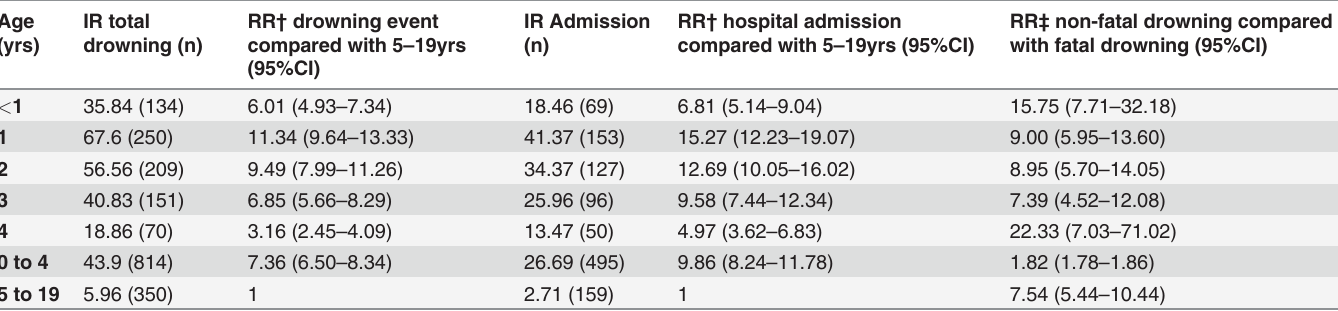
15 – 19yrs: Older adolescents were involved in 12% of incidents overall. Total drowning inci- dence rates almost trebled over the study (X 2 = 6.96; P > 0.01) primarily due to non-fatal events (X 2 = 5.31; P < 0.05). Although the rates for hospital admissions and non-admissions were simi- lar, the non-admission rate increased by a factor of 2.3 (X 2 = 11.12; P > 0.001) over the study. For male adolescents total drowning rates almost doubled (X 2 = 7.06; P < 0.01), and non- fatal and non-admission rates more than doubled (X 2 = 6.13; P < 0.01; X 2 = 8.72; P < 0.01) re- spectively. Mortality rates for females were the lowest rates in this age group; no fatalities were recorded for four years of the study. The risk of a male drowning was 1.4 times that of a female (95%CI = 1.00 – 1.99).